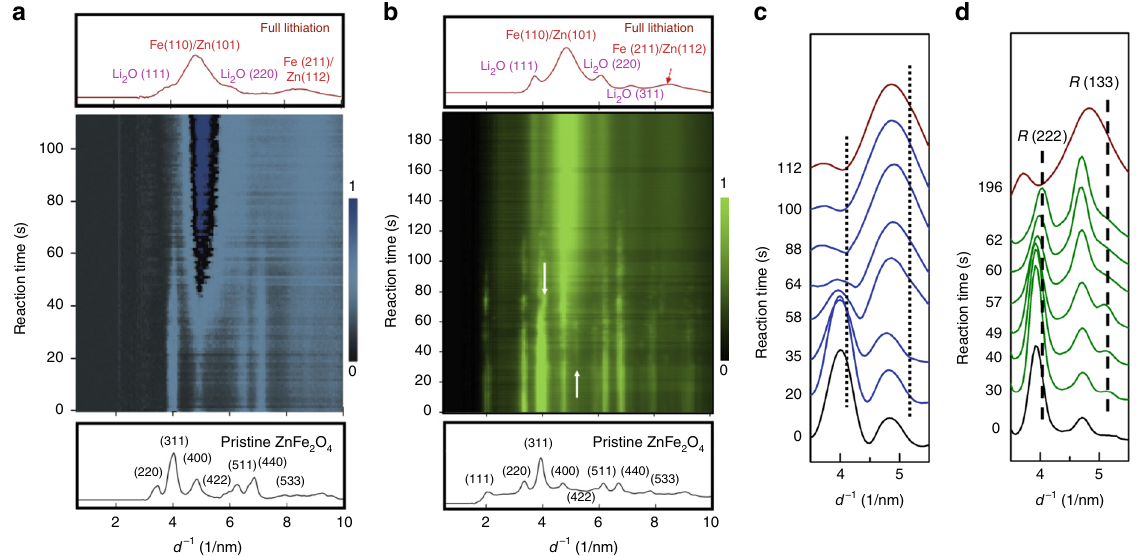
Fig. 2 Phase evolution tracked by in situ electron diffraction. Electron diffraction intensity pro fi les of a S-ZFO and b L-ZFO as a function of reaction time. The corresponding radial intensity spectrum of pristine (black) and fully lithiated (red) states are shown below and above the color map, respectively. c Radially integrated intensity pro fi les of S-ZFO as function of reaction time. The dotted lines point out the corresponding d-spacing of ordered rock-salt phase observed in d . d Radially integrated intensity pro fi les of L-ZFO as a function of time. The additional phase indicated by white arrows in b corresponds to the ordered rock-salt phase ( R (222) and R (133)), as indicated by black dashed lines validates the approach. It is worth noting that two additional because the 111 peak is too dim and close to the transmitted spot, peaks appear at the lower DOD for the L-ZFO (<60 s), indicated by which overwhelms the signal from it. For better visualization, we the white arrows in Fig. 2b. For clearer visualization, we extract and false-color the intensity pro fi le (see Supplementary Figure 5) of S- display the time-sequential intensity pro fi les of L-ZFO in the range ZFO with blue (Fig. 2a) and L-ZFO with green (Fig. 2b). For both where the new phase occurs, as shown in Fig. 2d. Comparing with samples, the initial sharp Bragg re fl ections associated with spinel the pristine state (black curve) and the fully lithiated state (red ZFO (bottom spectrum) gradually change with lithiation into curve), it can be seen that two distinct peaks emerge at 4.04 nm − 1 broadened peaks associated with Li 2 O and Zn 0 / Fe 0 (top spec- trum). This is the same as is observed in the ex situ data, which and 5.08 nm − 1 , which are associated with 222 and 133 re fl ections of NATURE COMMUNICATIONS| (2019) 10:93